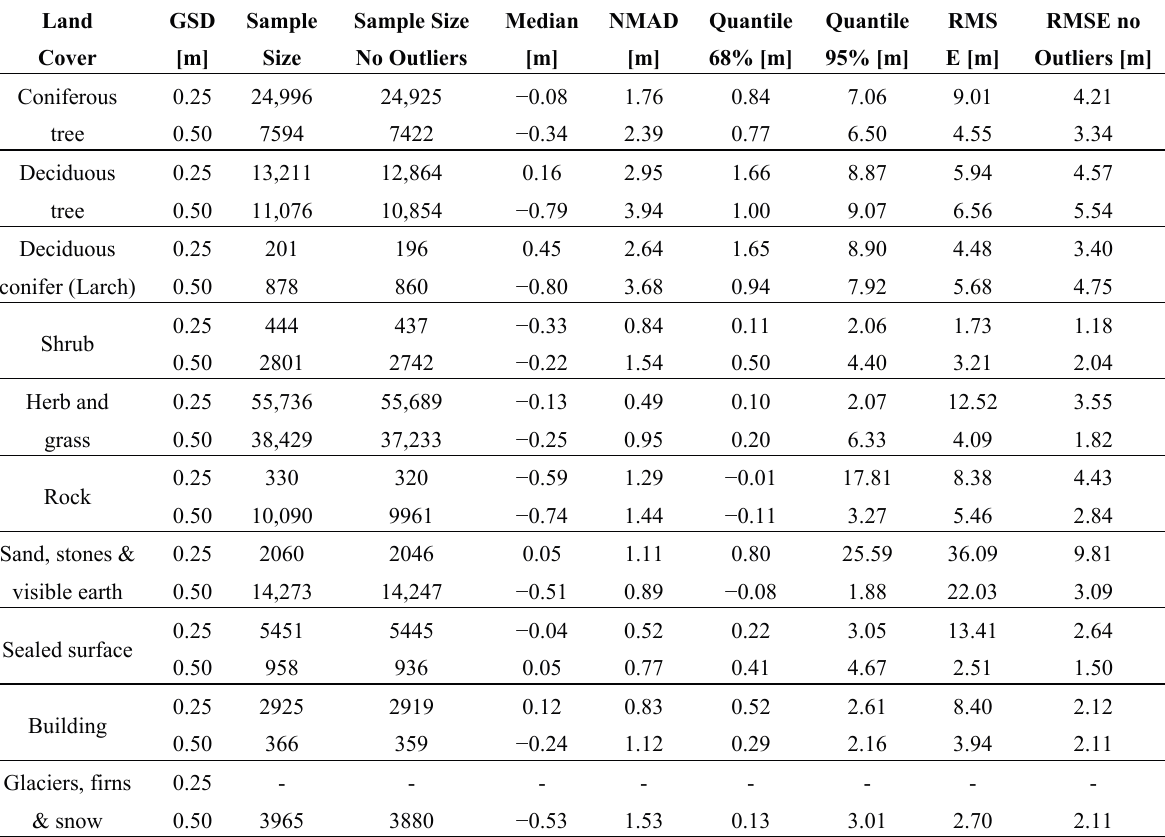
Table 4. Vertical agreement measurements of the digital surface model per land cover type based on stereo measurements. Differences were calculated by subtracting the